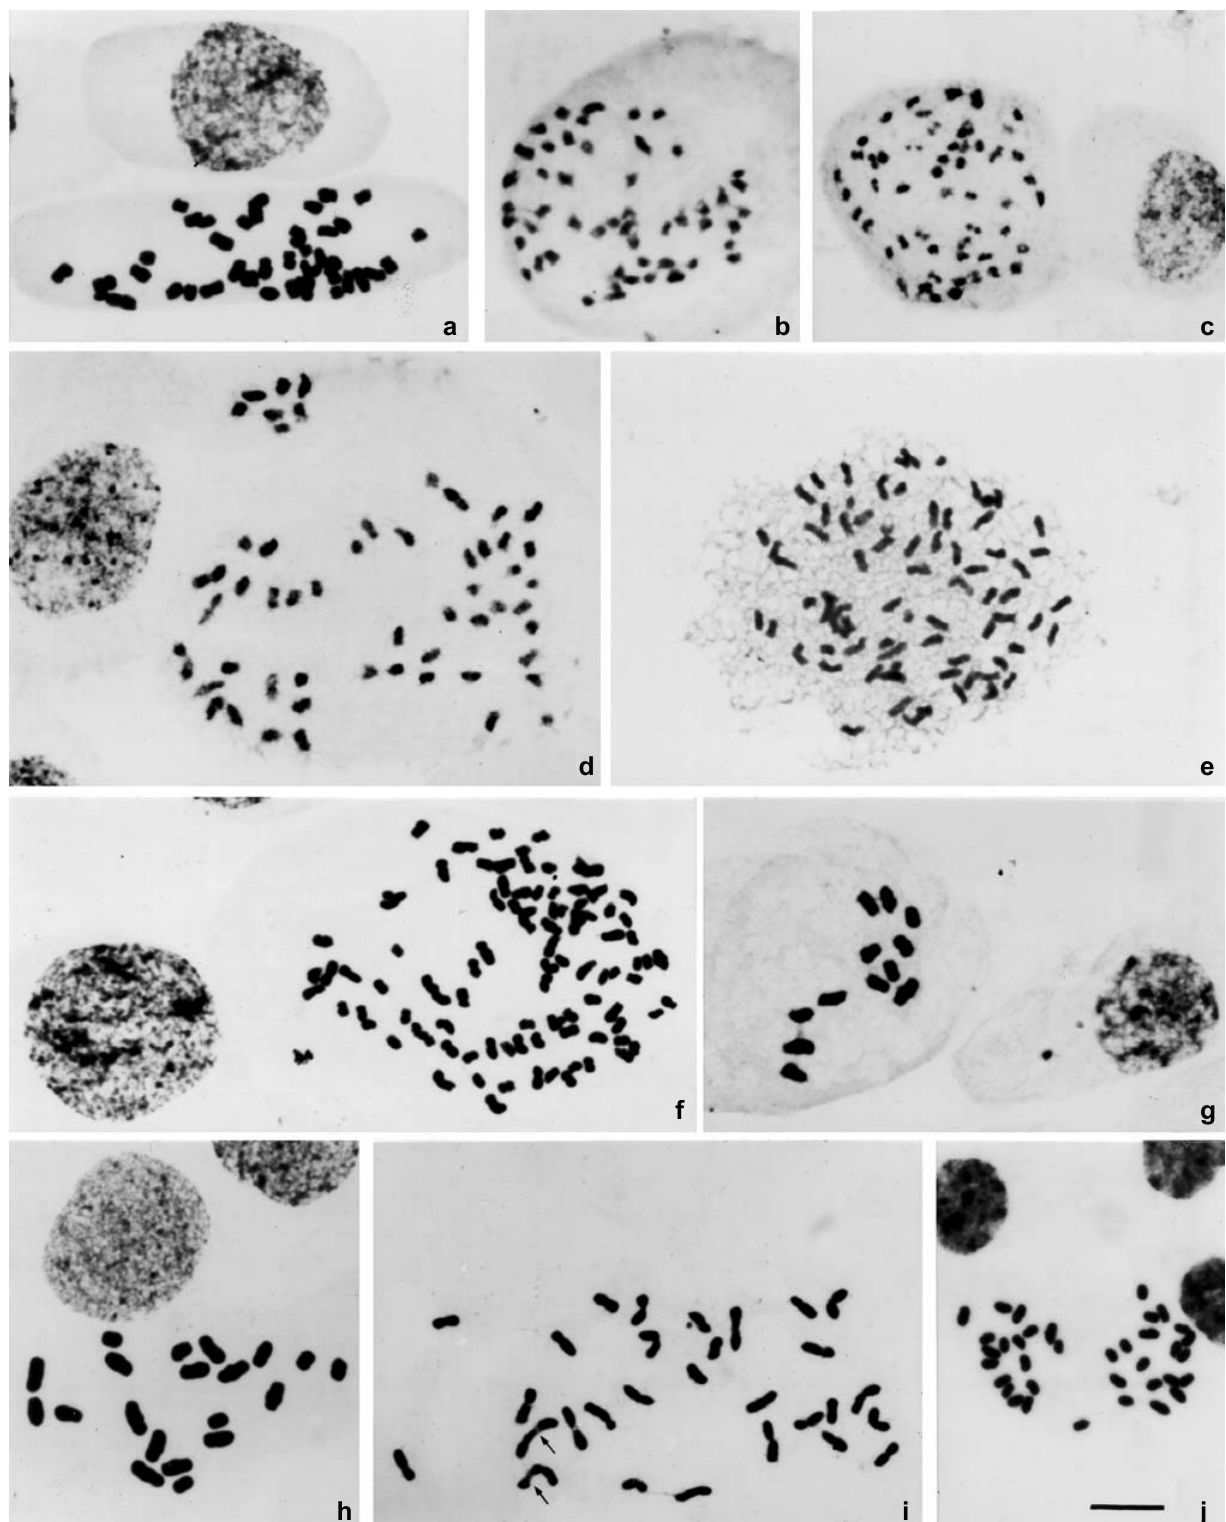
Figure 3 - Chromosome complements and interphase nuclei of orchid species of the subtribes Maxillariinae, Zygopetalinae, Lycastinae and Oncidiinae: ( a ) Maxillaria discolor (2n = 42); ( b ) Dichaea panamensis (2n = 52); ( c ) Dipteranthus duchii (2n = ca. 56); ( d ) Dipteranthus sp. (2n = 56); ( e ) Bifrenaria magnicalcarata (2n = 80); ( f ) Koelensteinia tricolor (2n = ca. 96); ( g ) Psygmorchis pusilla (2n = 12); ( h ) Trichocentrum cornucopiae (2n = 20); ( i ) Oncidium pumillum (2n = 30) (arrows indicate secondary constriction), and ( j ) O. cebolleta (2n = 36). Bar represents 10 µ